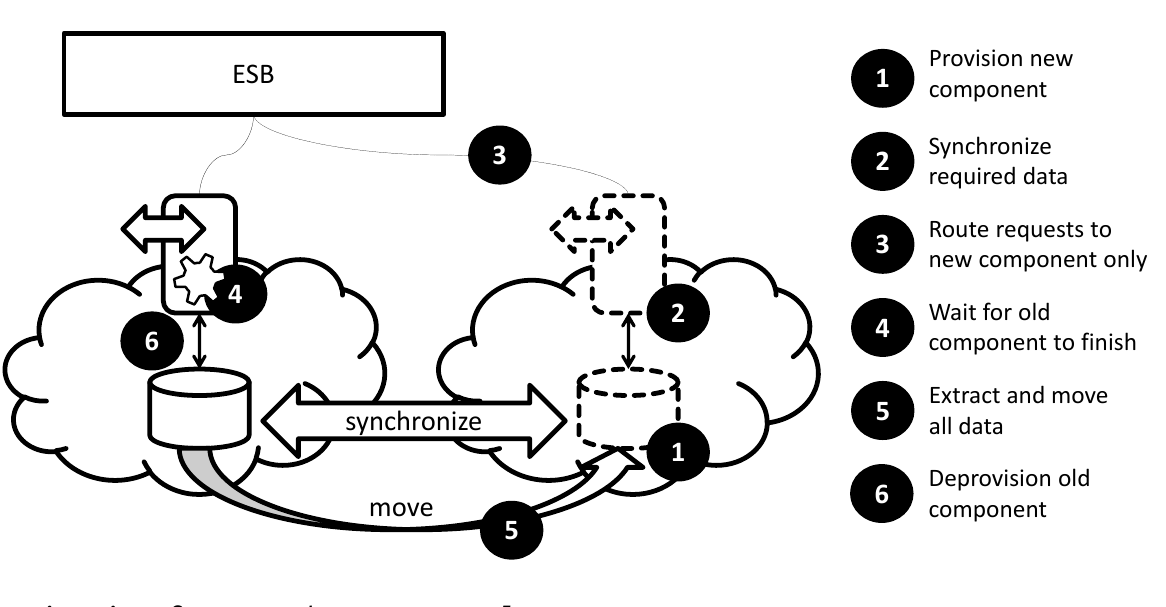
Figure 23. Steps to Move the Product Catalog